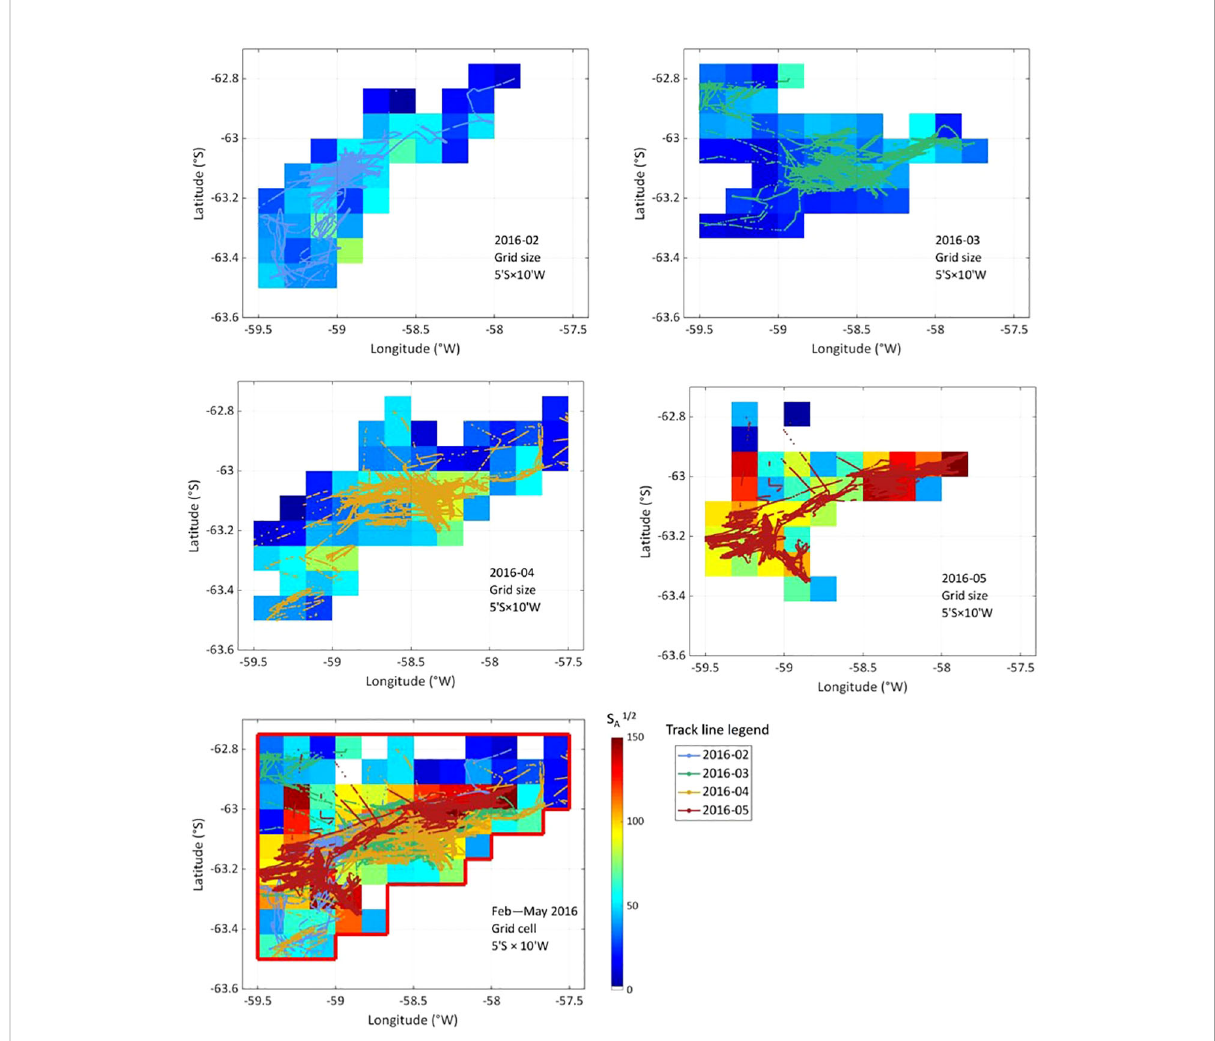
FIGURE 6 Monthly (February – May 2016) spatial distribution of nautical area scattering coef fi cient (NASC) values with a 5 ’ S × 10 ’ W grid